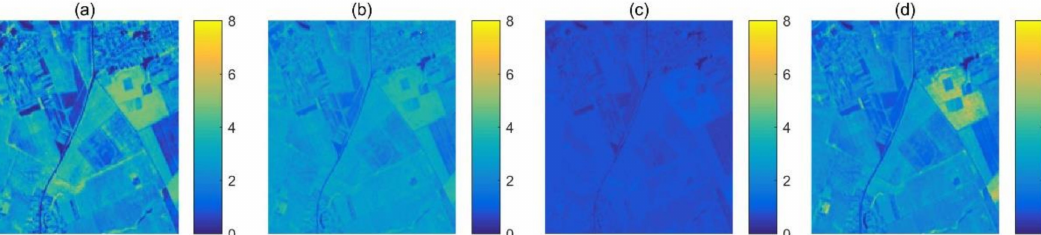
Figure 9. LAI maps with 30 m spatial resolution at the Pshenichne site. ( a ) Based on the model-downscaling method proposed in this paper; ( b ) based on Ovakoglou’s downscaling method; ( c ) based on the model F ( P ) ; ( d ) the reference LAI map with 30 m spatial resolution obtained from the ImagineS